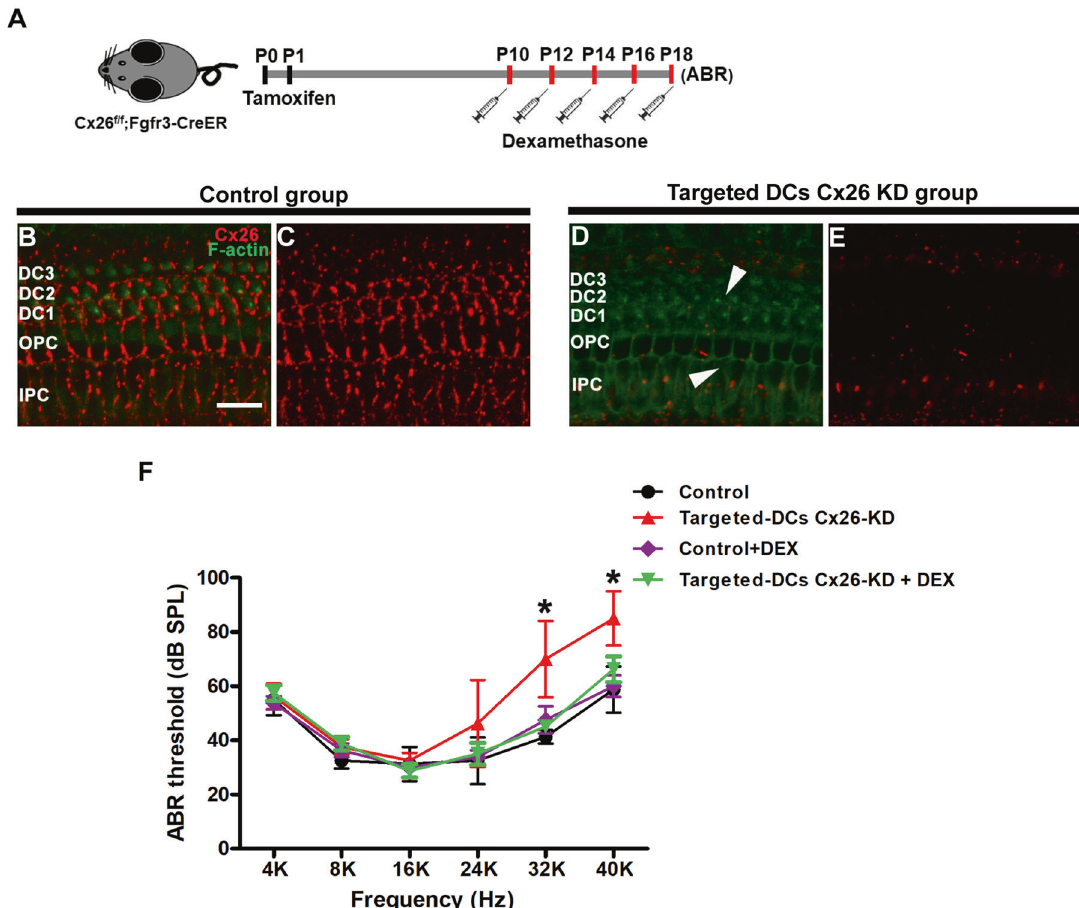
Fig. 4 Effects of dexamethasone on the hearing loss in DC-targeted Cx26-null mice. A Schematic of the experimental work fl ow, Cx26 f/f ; Fgfr3-CreER mice were injected with TMX and then treated with dexamethasone 5 mg/kg of body weight for fi ve days. B , C Cx26 immunolabeling (red) in the apical of the control group. D , E Cx26 immunolabeling (red) in the apical of the targeted DCs Cx26-null group. The white arrowheads in panel ( D ) indicate that Cx26 of DCs was successfully knocked out. F ABR thresholds were analyzed indifferent group at P18. n = 5 mice in each group, * P < 0.05. Scale in panel ( B ) represents for 40 μ